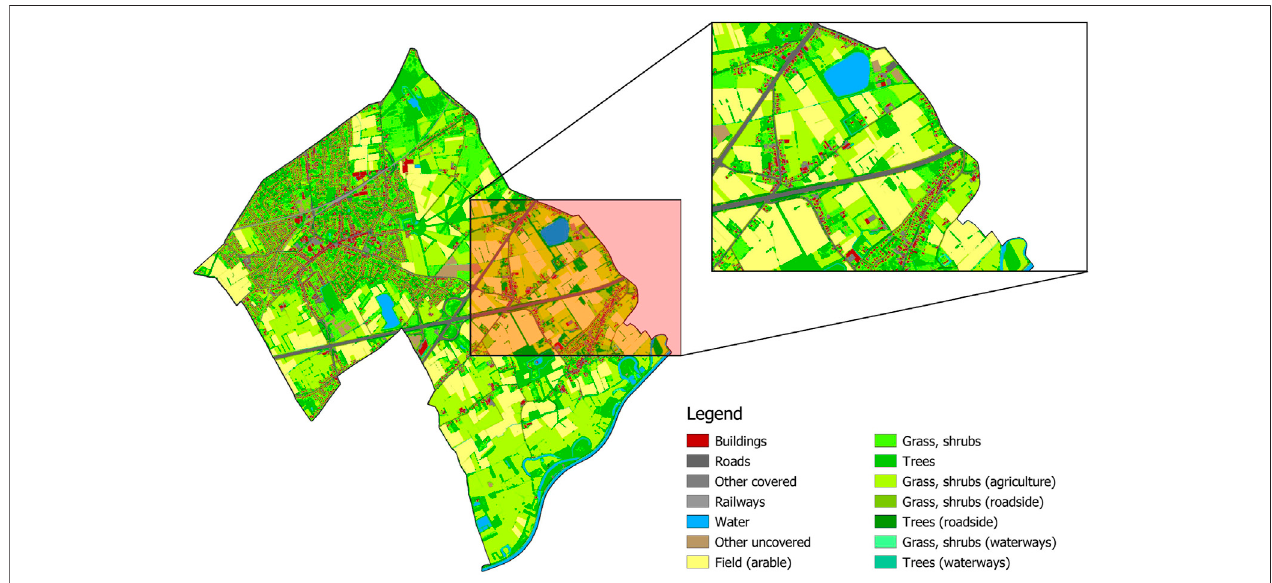
FIGURE 4 | Ground cover